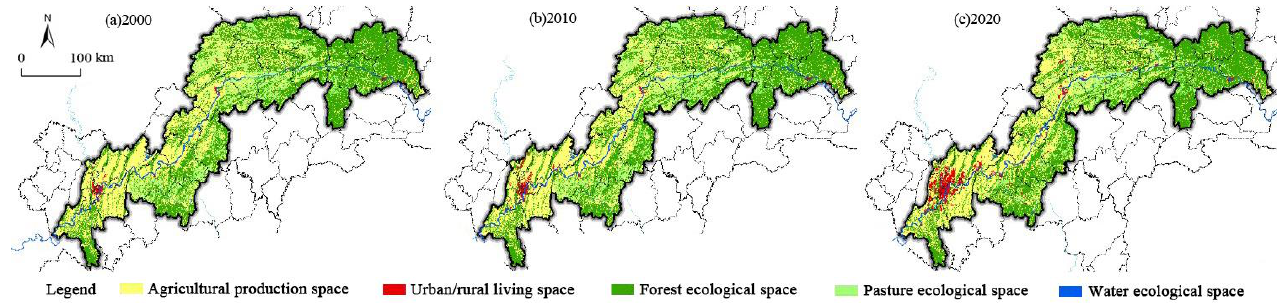
Figure 2. Spatial evolution pattern of the PLES in the TGRR from 2000 to 2020. Table 2. Spatial evolution of the PLES in the TGRR from 2000 to 2020 (km 2 ).